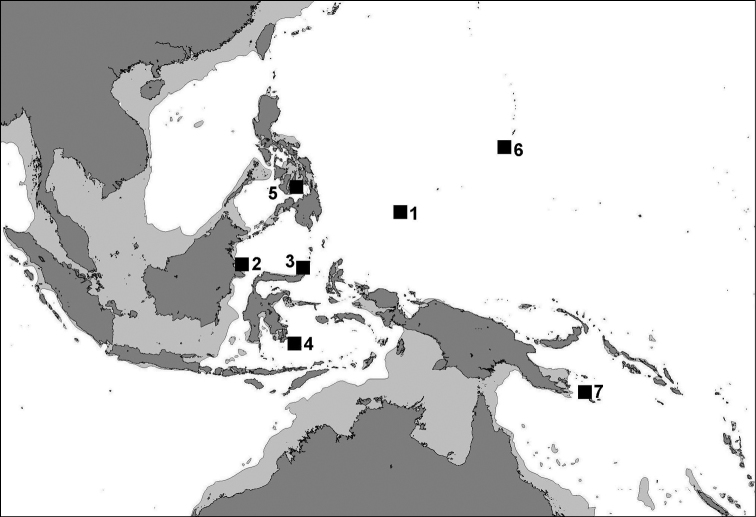
Distribution map ofLeptoseris troglodyta sp. n. showing records at (1) Palau, (2) East Kalimantan, (3) North Sulawesi, (4) Wakatobi, (5) Bohol, (6) Guam, (7), eastern Papua New Guinea.